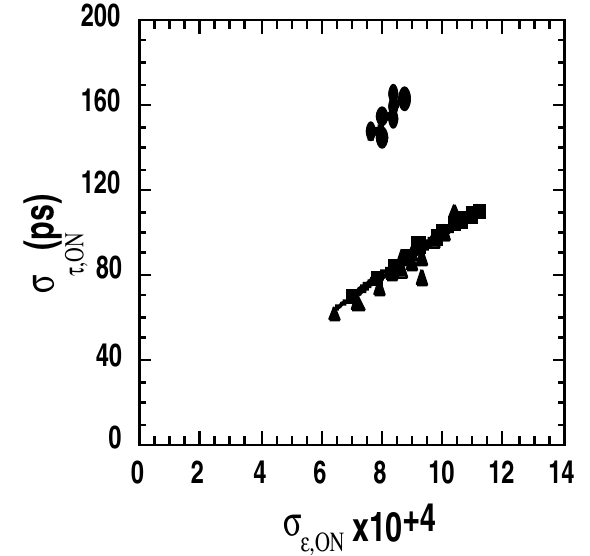
FIG. 5. Bunch length (+) versus energy spread both measured (cid:1) 0 kV ; ( (cid:1) ) for V under laser heating: ( (cid:2) ) for V h (cid:1) 120 kV . and ( (cid:3) ) for V h